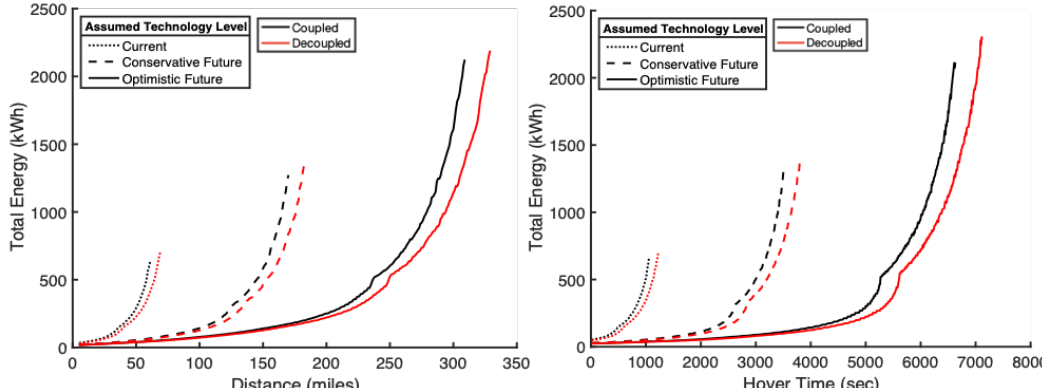
Figure 12. The single-main-rotor helicopter total energy consumption per mission distance and hover time for the coupled and decoupled